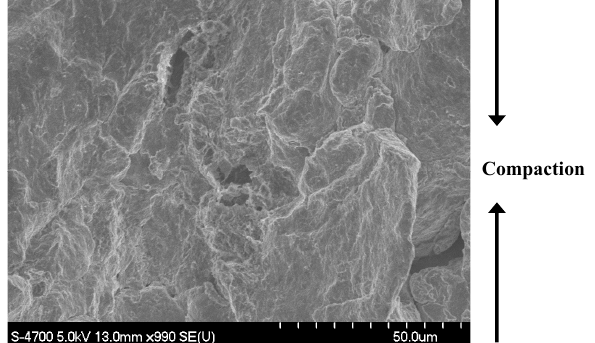
Figure 9. Higher magnification SEM micrograph of P/M AZ31 alloy sintered at 500 °C (500 MPa, 20 min, 450 °C).